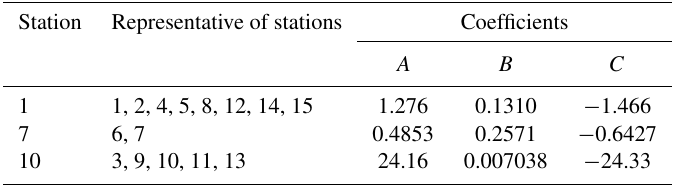
Table 4. Calibration coefficients for converting relative dielectric permittivity measurements by 5TM sensors to volumetric soil moisture content.